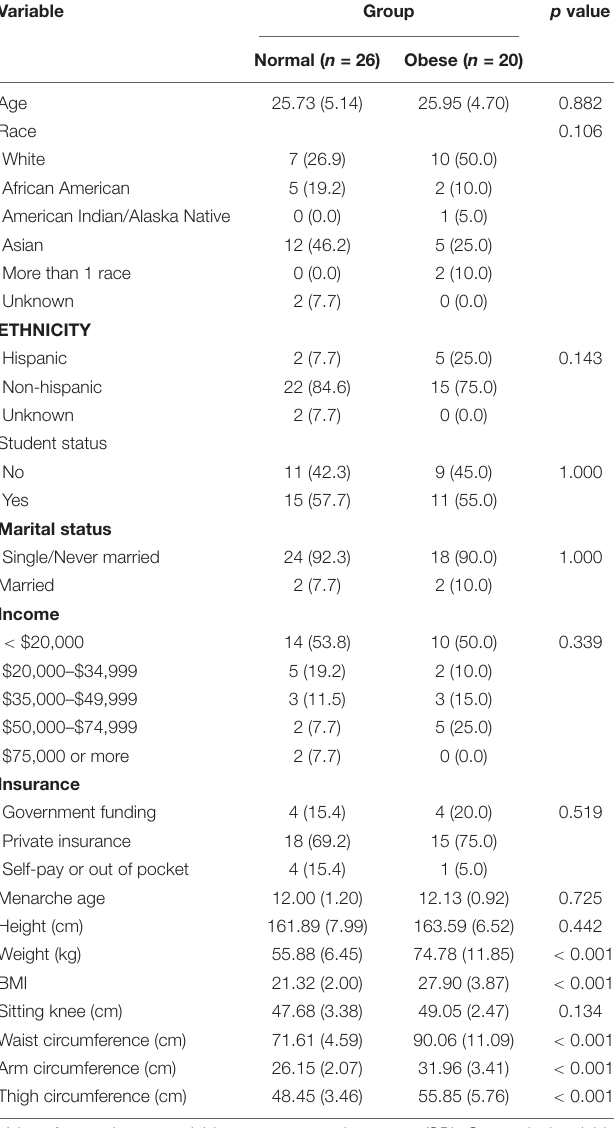
TABLE 1 | Demographic and anthropomorphic characteristics of study groups.